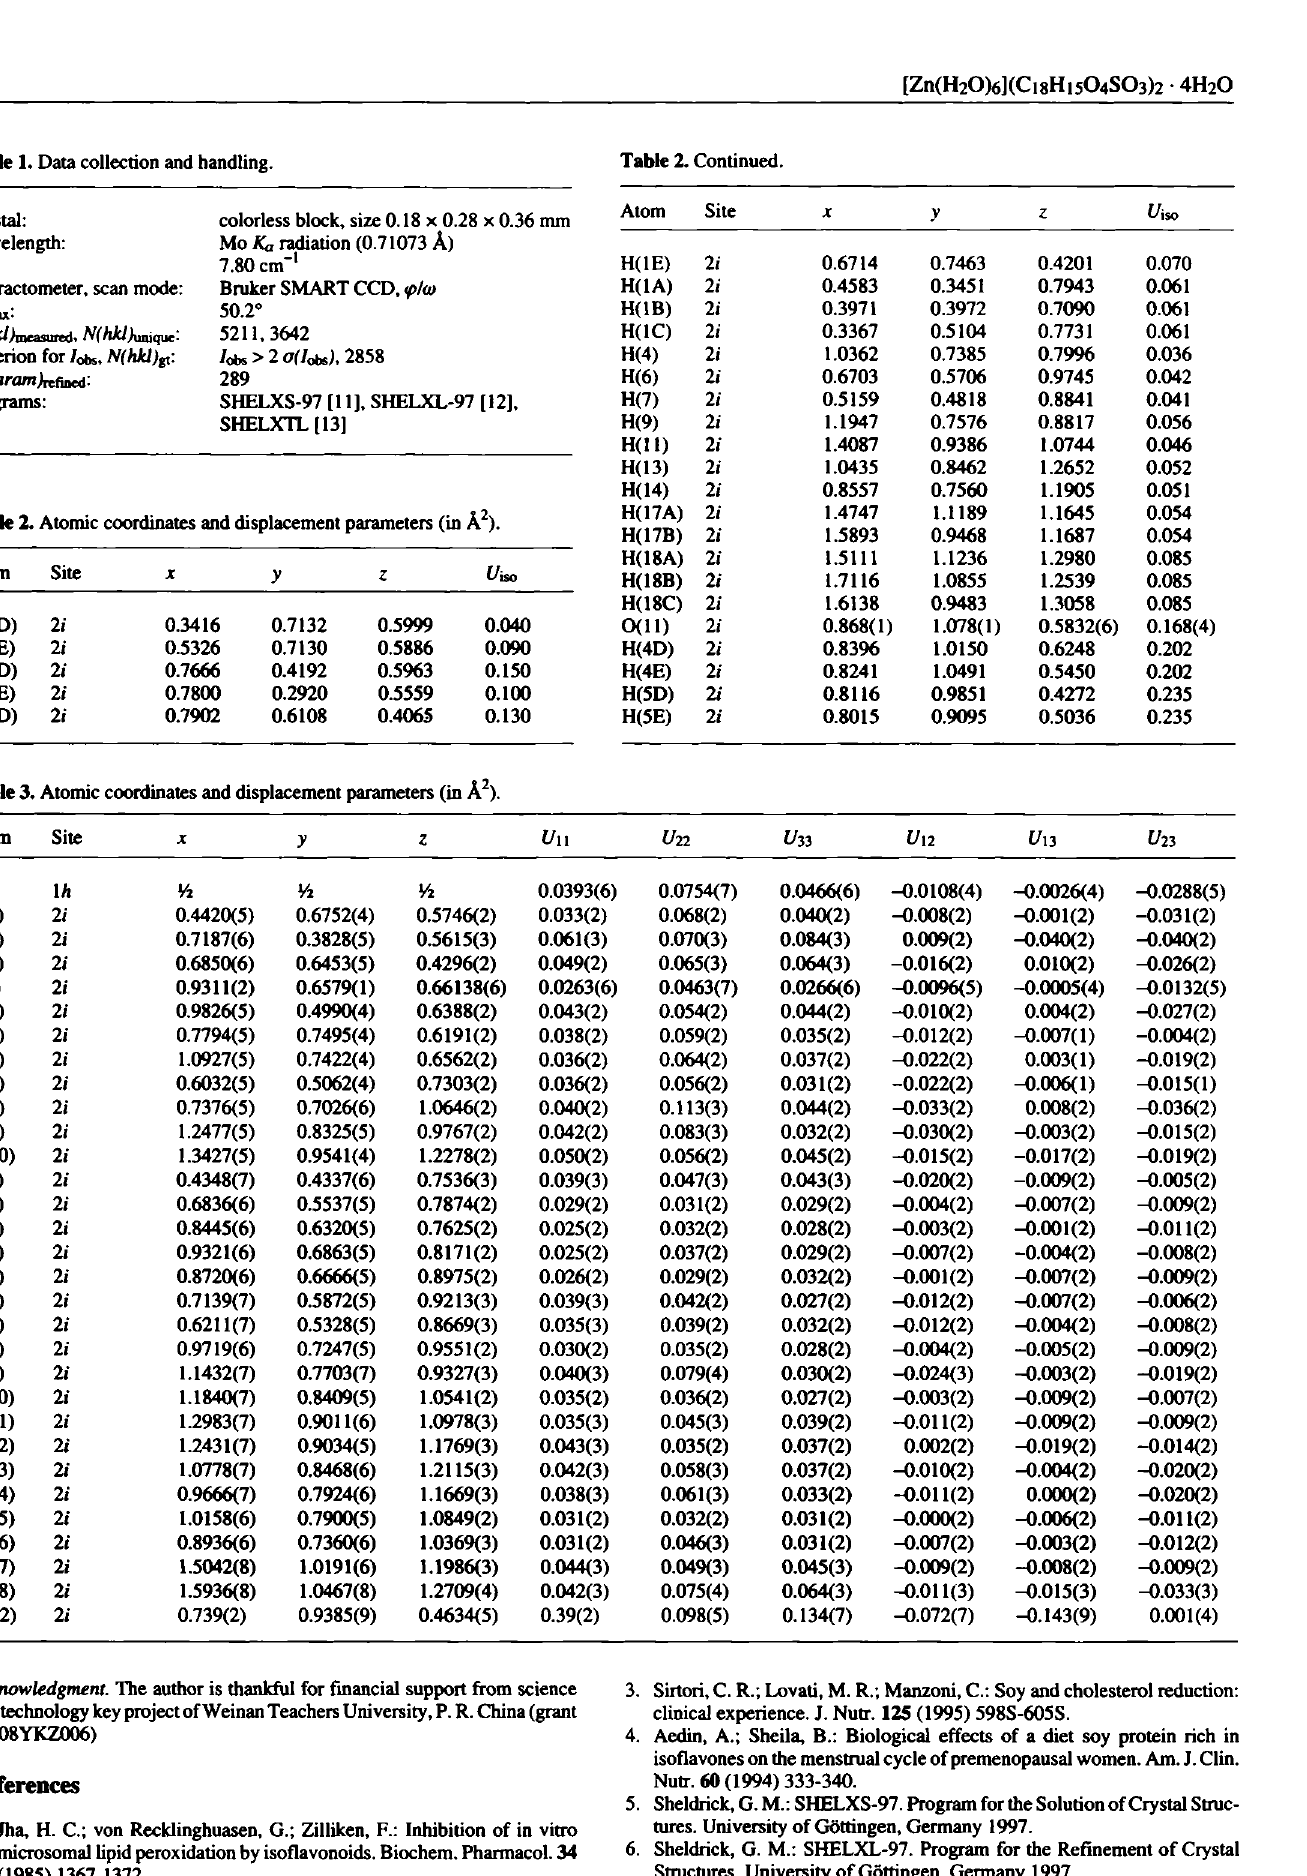
Table 2. Atomic coordinates and displacement parameters (in Â 2 ).